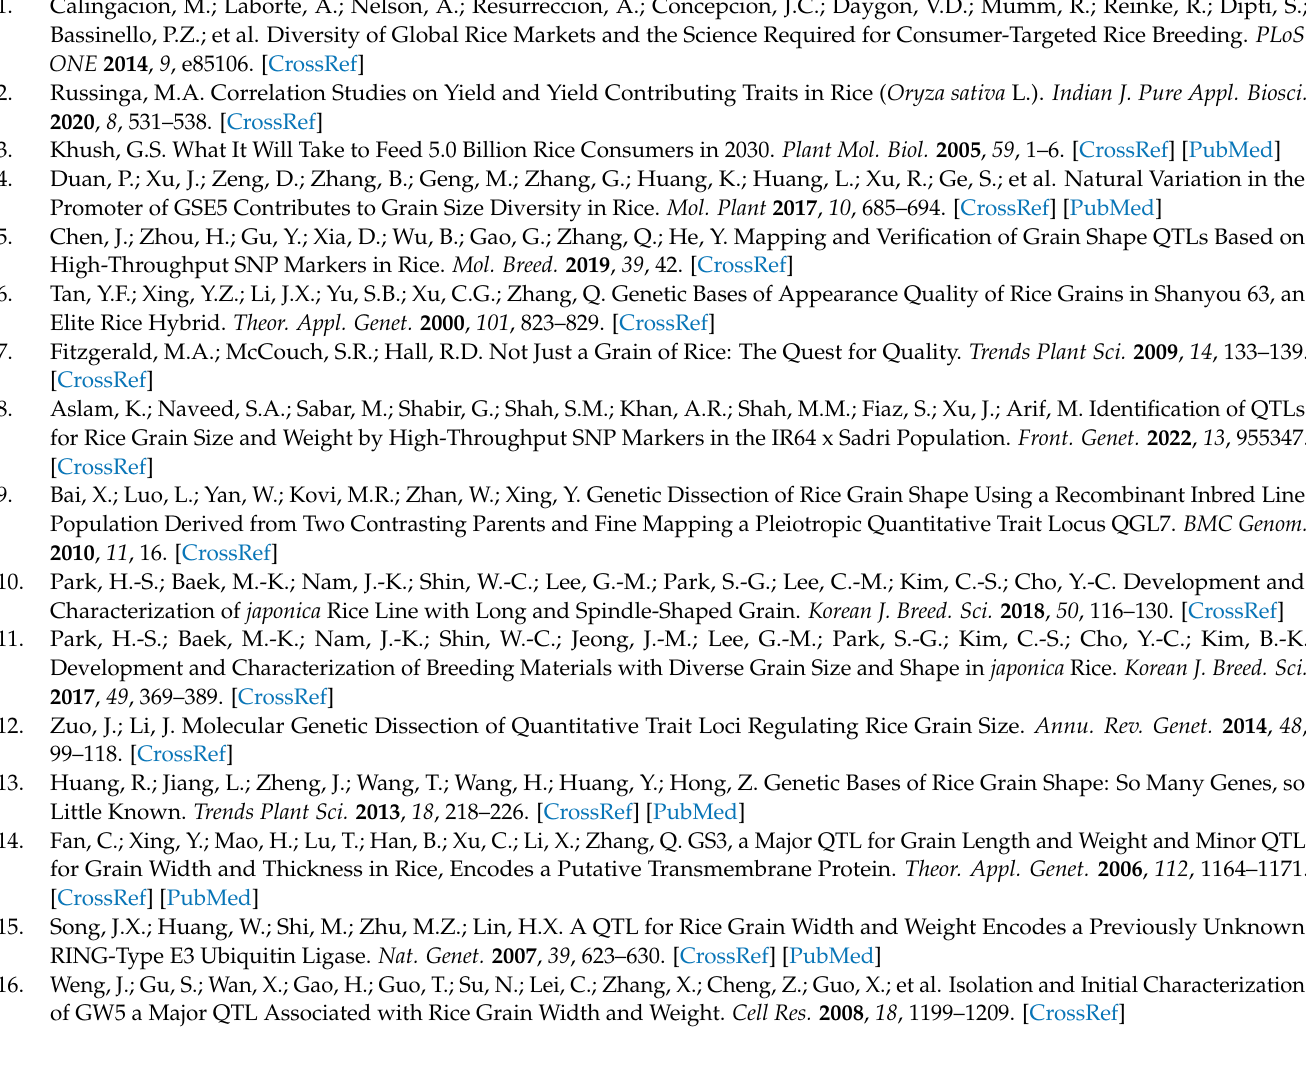
QTLs associated with grain shape tested on chromosomes 2, 5, and